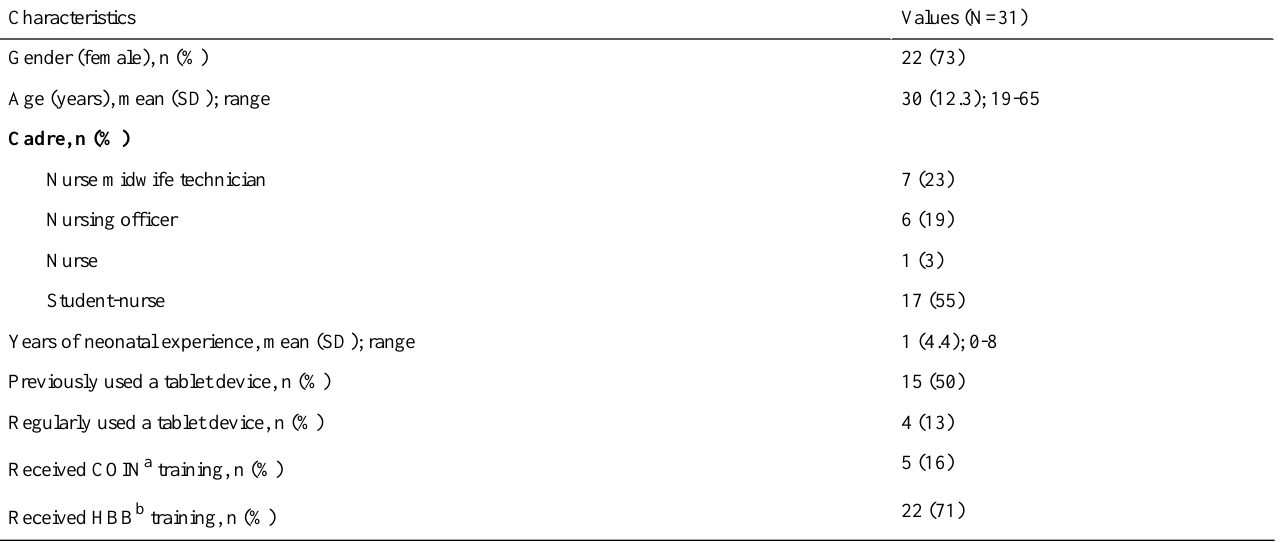
Table 1. Participant